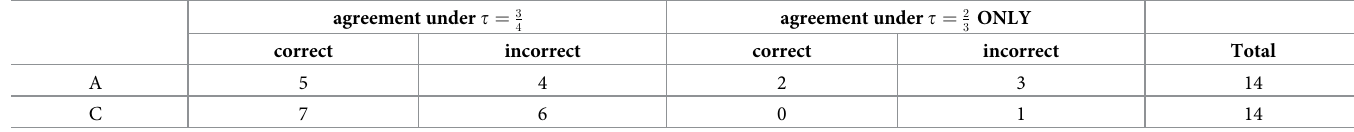
Table 6. Agreement of the annotators under each threshold τ on the annotation values A and C, correctly or incorrectly.